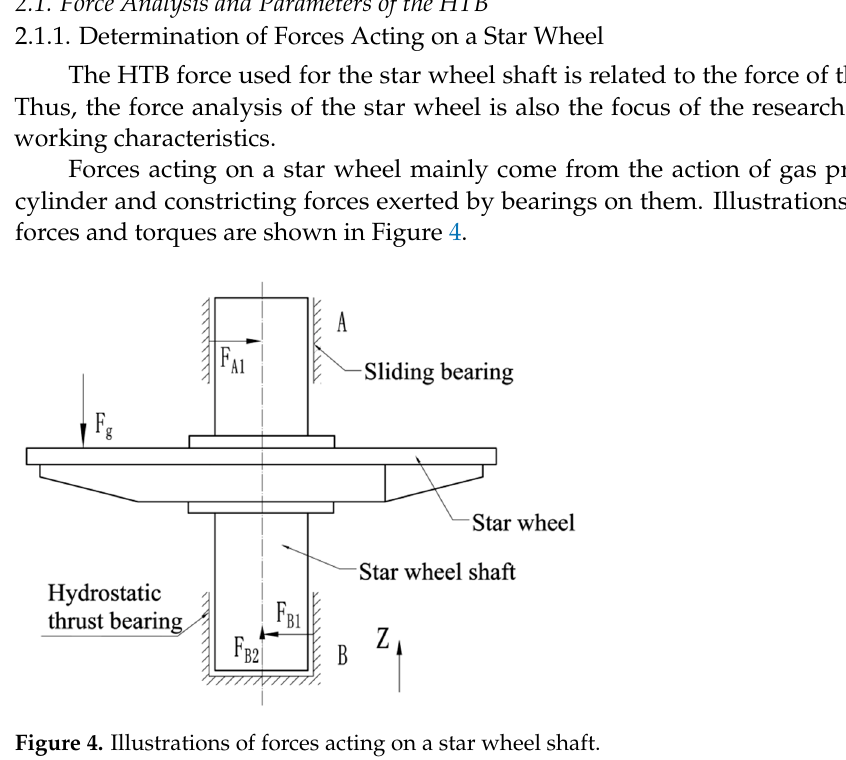
Figure 3. Workflow of the methodology.